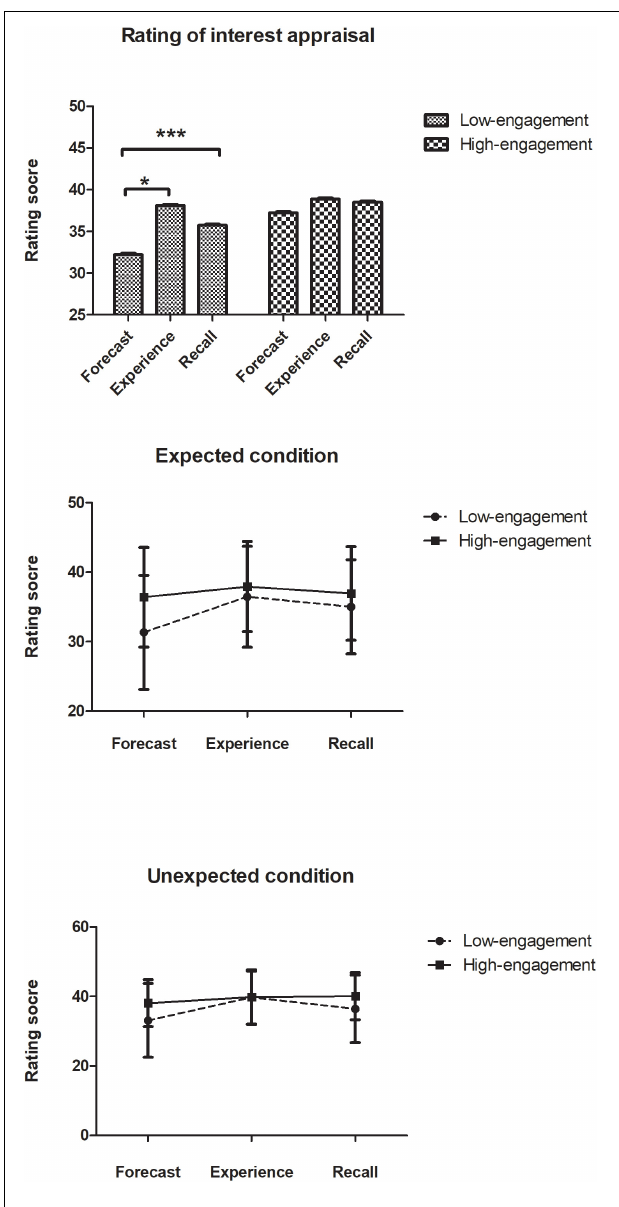
FIGURE 2 | Participants’ rating scores for emotions in three-time points (forecasts, experience, and recall) under different